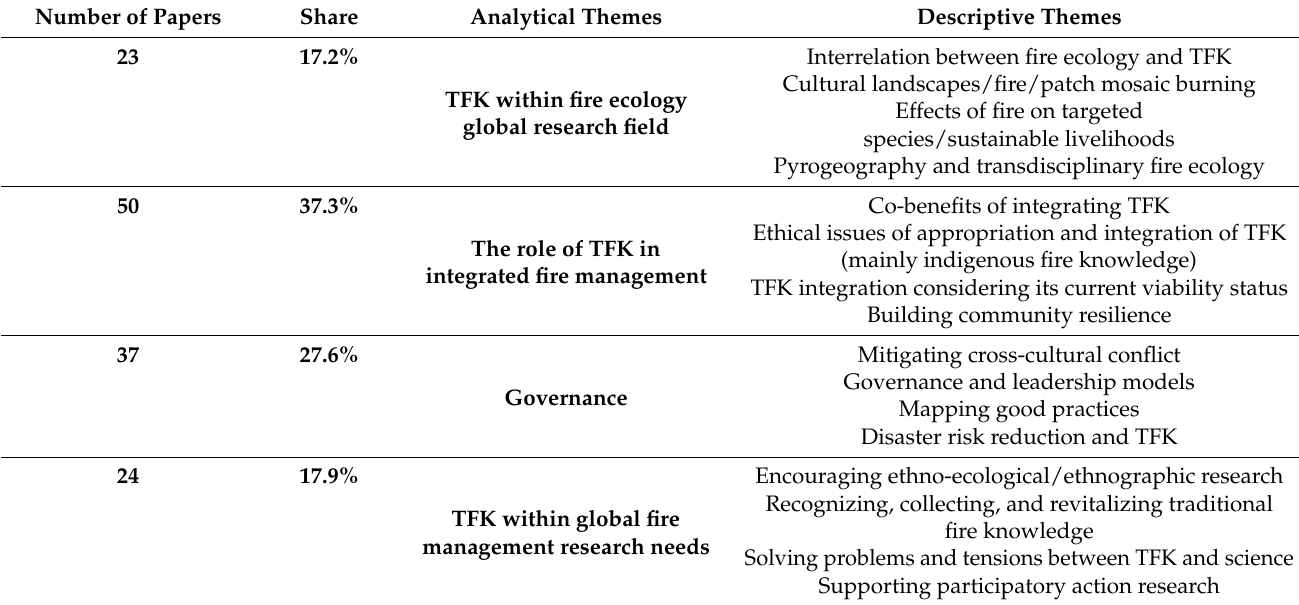
Table 4. Breakdown of descriptive themes, main analytical themes, and their relative